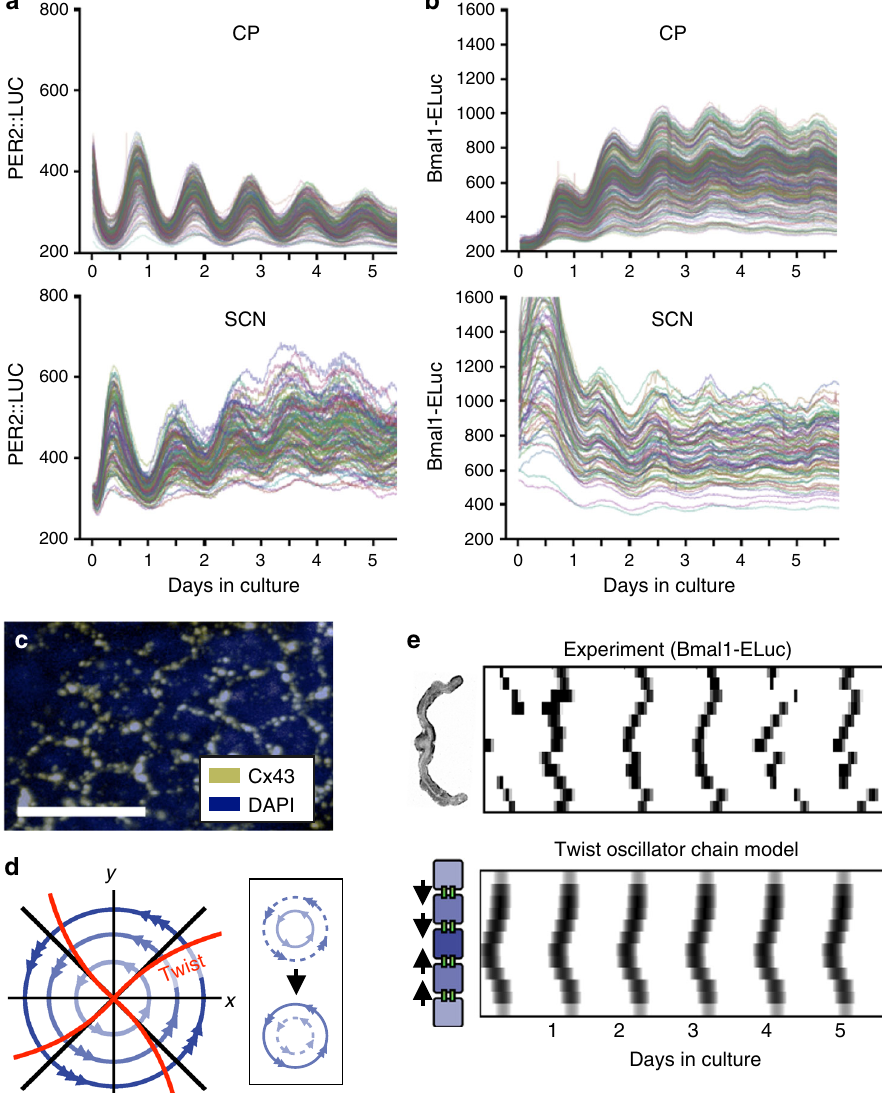
Fig. 2 The robust circadian clock in the CP is due to strong synchronization through gap junction coupling. a Single-cell level circadian oscillation of PER2:: LUC activity in the CP (upper) and the SCN (lower). b Single-cell level oscillations of Bmal1-ELuc. In the SCN, each time series tracks changes of bioluminescence in a square region-of-interest (ROI) of single-cell size. ROIs of the same dimension are used on distinct regions in the CP as single cells were visually indistinct. c Immunohistochemistry against the gap junction subunit Cx43 shows its expression between cells of the CP. Scale bar indicates 50 μ m. d For self-sustained oscillators exhibiting negative twist, an increasing (instantaneous) amplitude transiently leads to a decreasing (instantaneous) period as the oscillator returns to its steady-state oscillation. Isochrons represent lines in the phase space with identical oscillator phases as time t goes to in fi nity 65 (see Methods). In systems without twist, isochrons form straight radial lines (thick black lines). In oscillators with negative twist, isochrons become bent or “ twisted ” (thick red line). In networks of interacting oscillators, coupling can expand the amplitude of single-cell oscillators and speed up the oscillation under negative twist (inset). See Supplementary Fig. 3 for detailed illustrations. e Cellular circadian oscillations in the entire 4V CP can be observed in vivo (upper left). In culture, Bmal1-ELuc oscillation shows spatial patterning of the peak phase of its circadian oscillation, which is statistically signi fi cant for the fi rst 3 – 4 days (see Supplementary Fig. 4). The central region of the 4V CP phase leads (upper), which can be explained by the boundary value condition in the nearest neighbor coupling of gap junctions